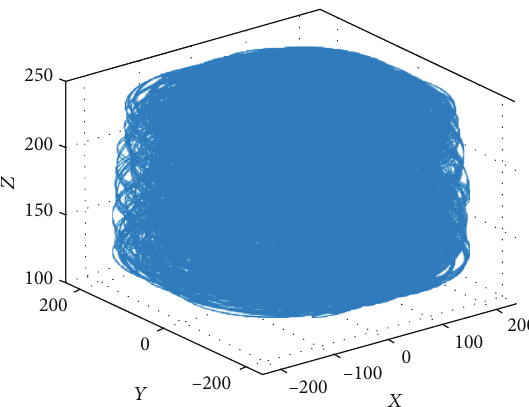
Figure 11: Simulation results of MRI-compatible breast interventional robot workspace.